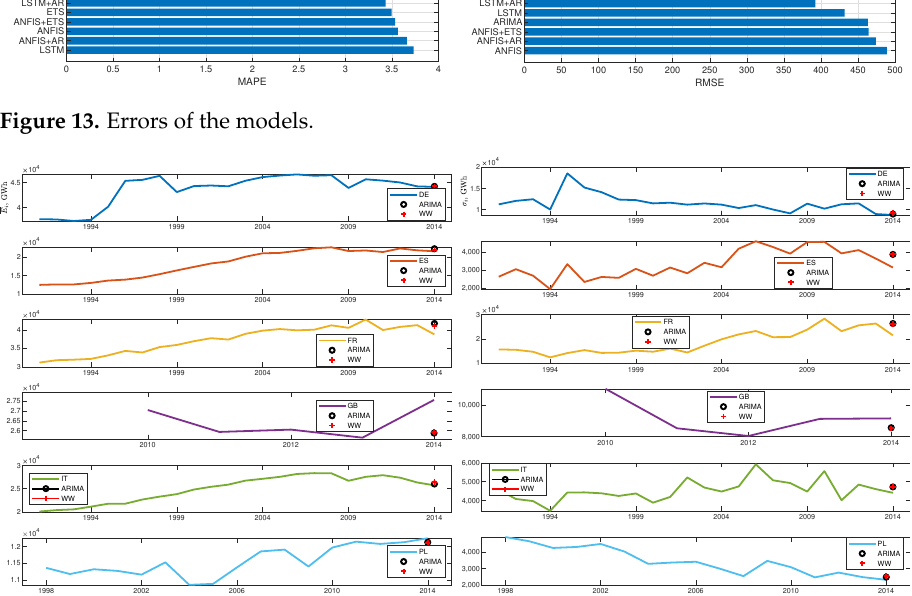
Figure 14. Forecasts of coding